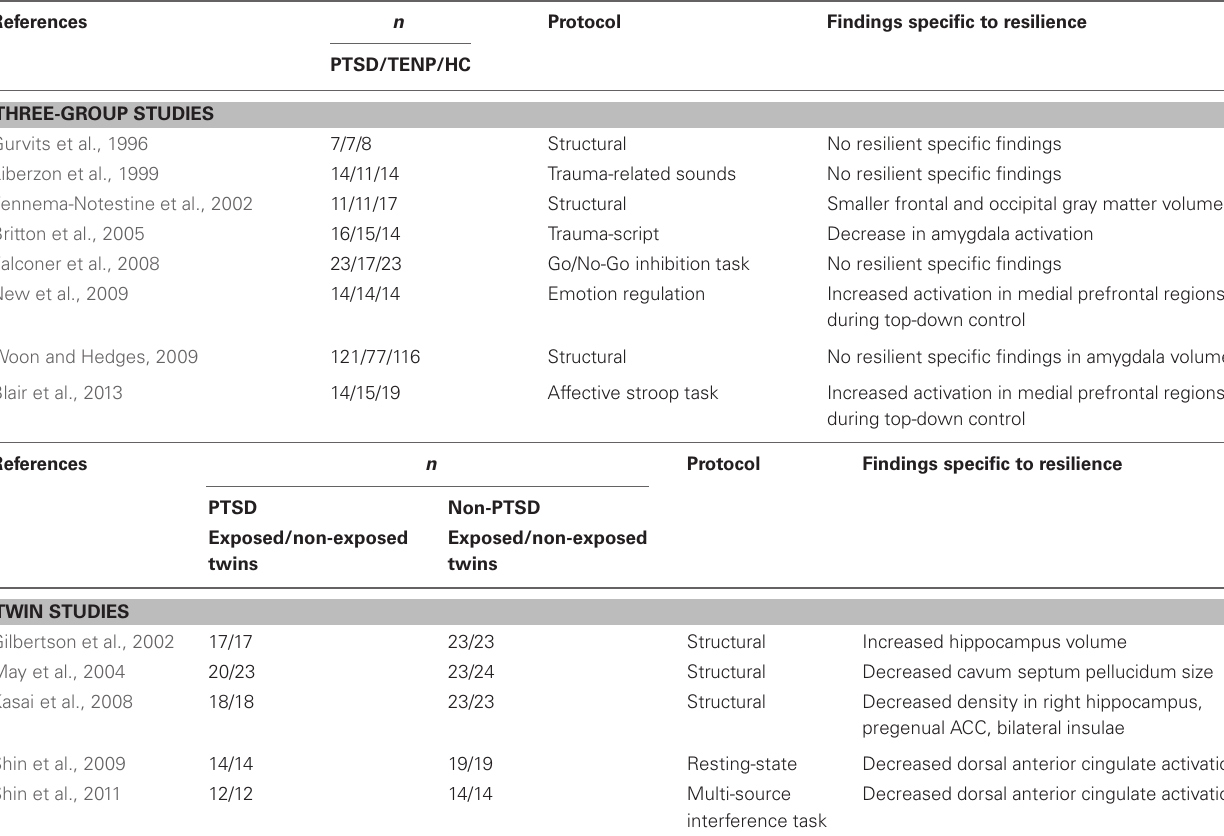
Table 1 | An overview of neuroimaging studies specifically examining resilience by using comparisons between three groups: (1) a PTSD group, (2) a TENP group, and (3) a healthy control group without both trauma exposure and